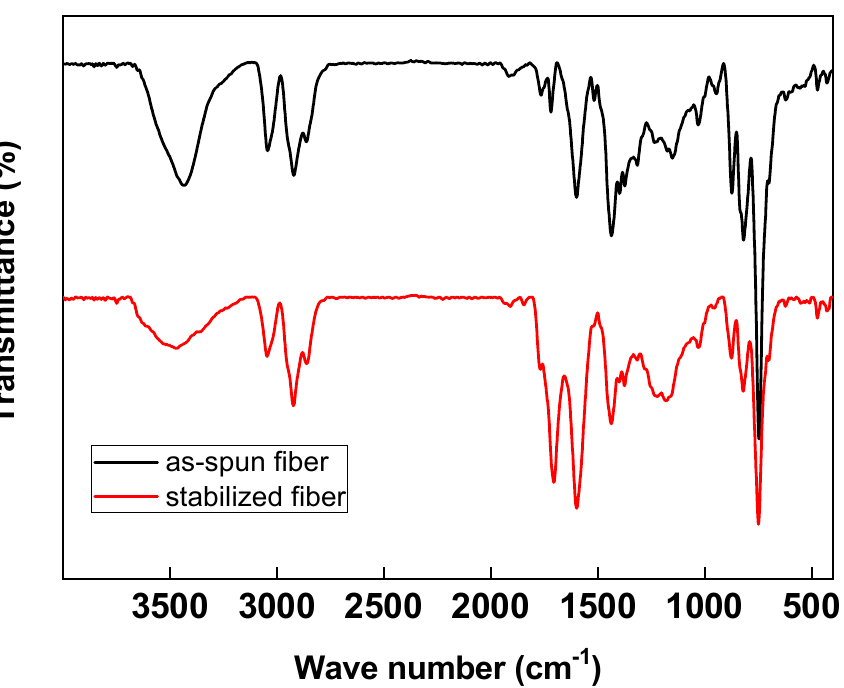
Figure 4. IR peaks of as-spun fiber and stabilized fiber from C33P67 in an air atmosphere at 270 °C for 1 h.